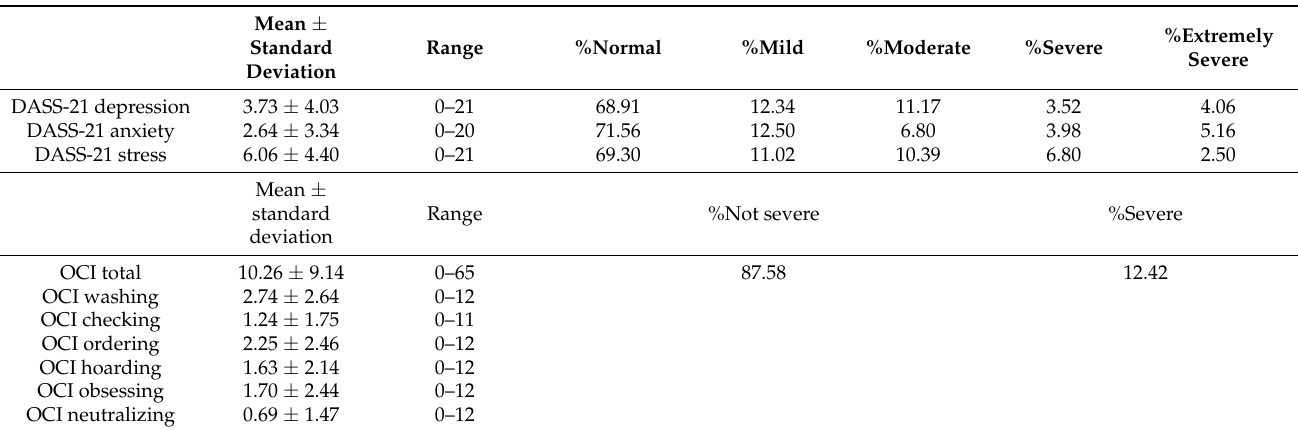
Table 2. Description of depression, anxiety, stress and obsessive-compulsive